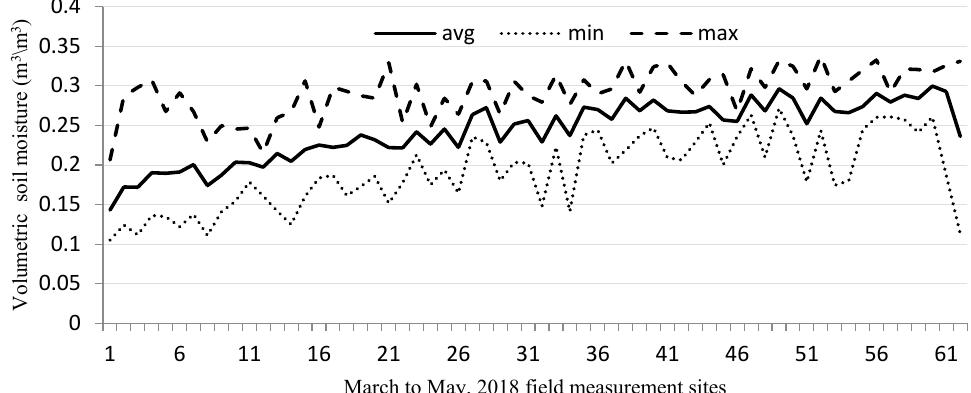
Figure 3. Observed soil moisture of each point during six passes of the satellite estimated using the gravimetric method during 2017.